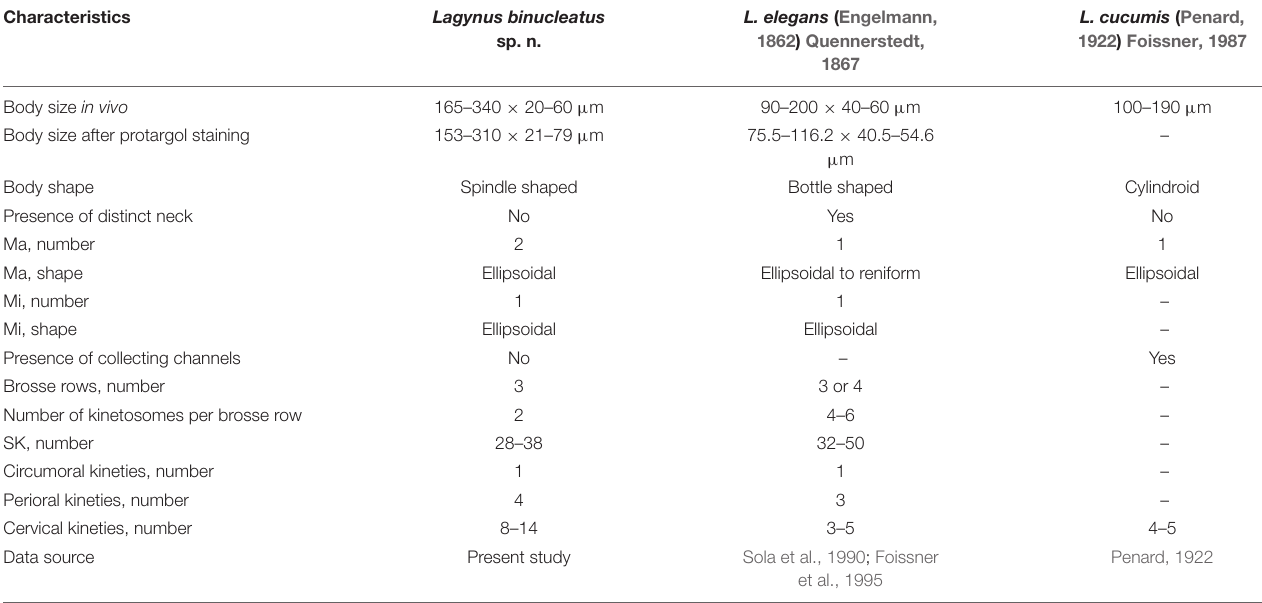
TABLE 2 | Comparison of Lagynus binucleatus sp. n. with congeners. Characteristics